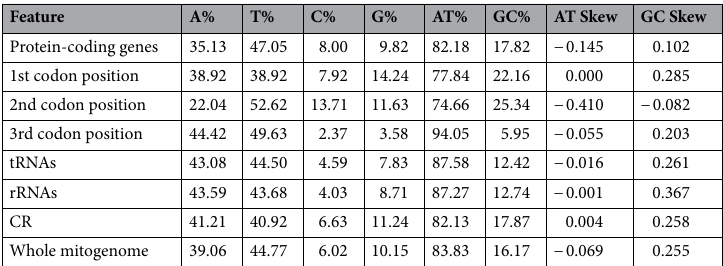
Table 2. Nucleotide composition of A. fulloi mitochondrial